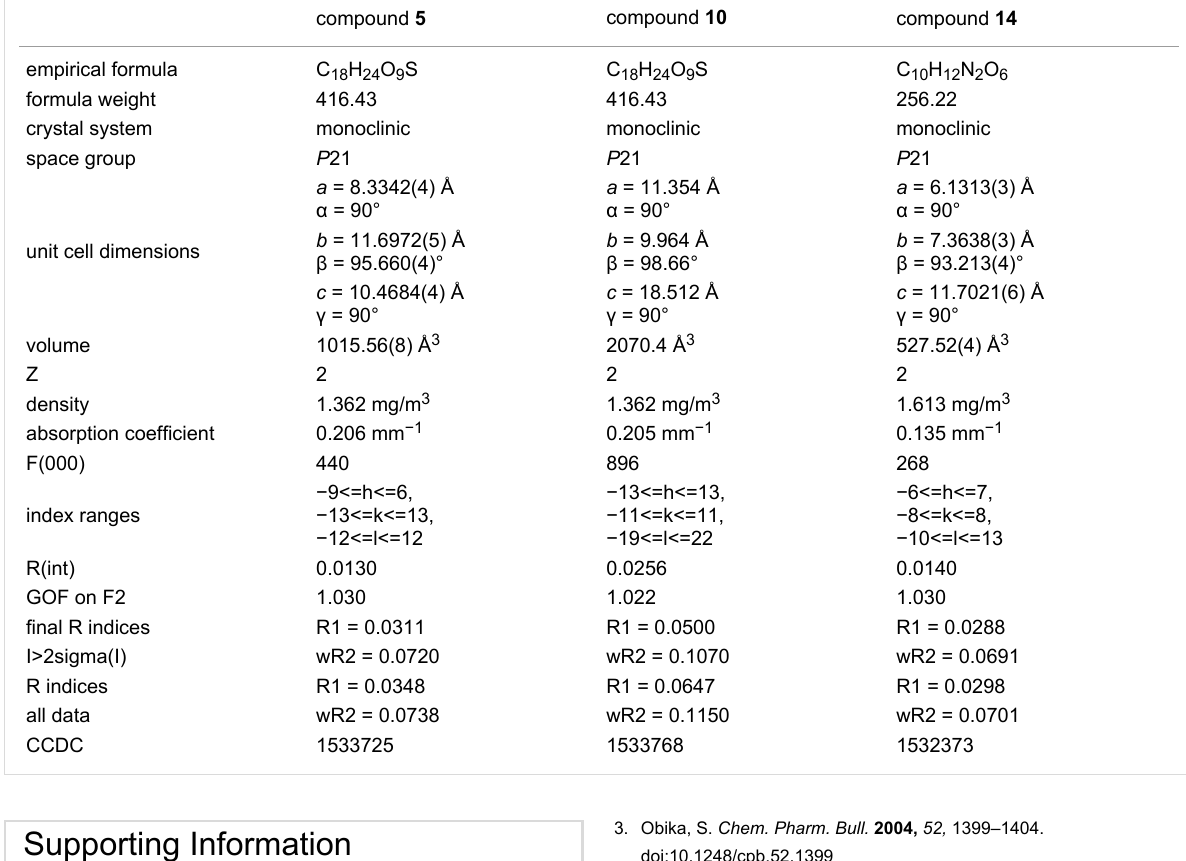
Table 1: Single crystal X-ray diffraction data of tosylated sugar derivatives 5 , 10 and 2 ′ - O ,4 ′ - C -methylene-xylouridine ( 14